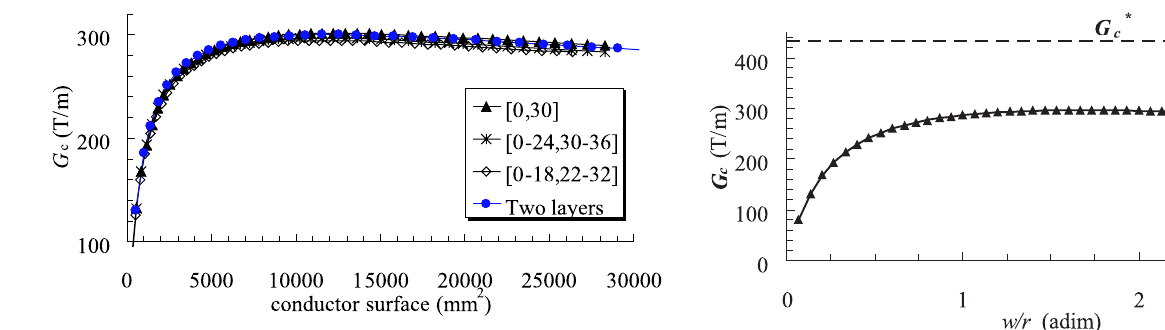
FIG. 13. Critical gradient versus sector width for the 0– 24,30 (cid:9) –36 sector: numerical results (markers) and analytical approximation by (37) (solid